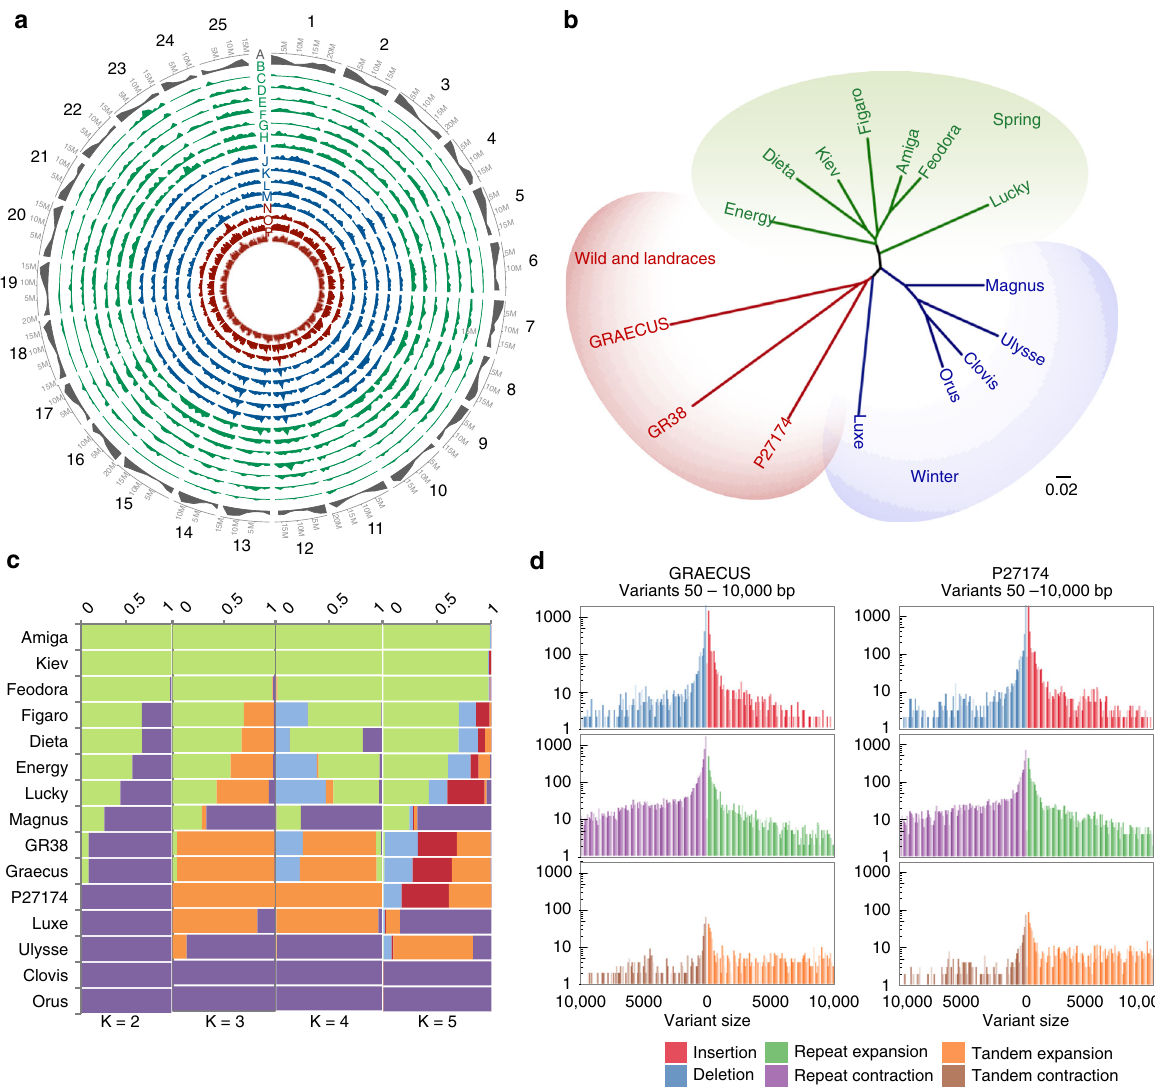
Fig. 2 White Lupin diversity and evolution history. a SNP density identi fi ed by resequencing of 15 accessions of white lupin. In the outer track (A in gray) gene density is shown. Spring accessions are represented in green (B – H), winter accessions are represented in blue (I – M) and wild/landrace accessions are represented in red (N-P). From the outer to inner track: (B) AMIGA, (C) FEODORA, (D) KIEV, (E) DIETA, (F) FIGARO, (G) ENERGY, (H) LUCKY, (I) ORUS, (J) CLOVIS, (K) MAGNUS, (L) ULYSSE, (M) LUXE, (N) P27174, (O) GR38, AND (P) GRAECUS. The SNP density is represented in 1 Mb bins. b Neighbor-joining phylogenetic tree of white lupin accessions based on SNPs. The 15 accessions are divided in three clades: winter, spring and wild/ landrace. c Admixture representation of the 15 accessions with population clustering for K = 2 – 5. Each individual is represented by a horizontal bar and each color represents a subpopulation. The color of each individual accession represents their proportional membership in the different populations. d Structural variants (SVs) between L. albus cv. AMIGA and the de novo assembly of GRAECUS (left) and P27174 (right). The biggest proportion of variants are the repeated elements. SVs represent 18.08 Mb of the GRAECUS genome and 18.67 Mb of P27174 genome. Source data underlying Fig. 2b are provided as a Source Data fi